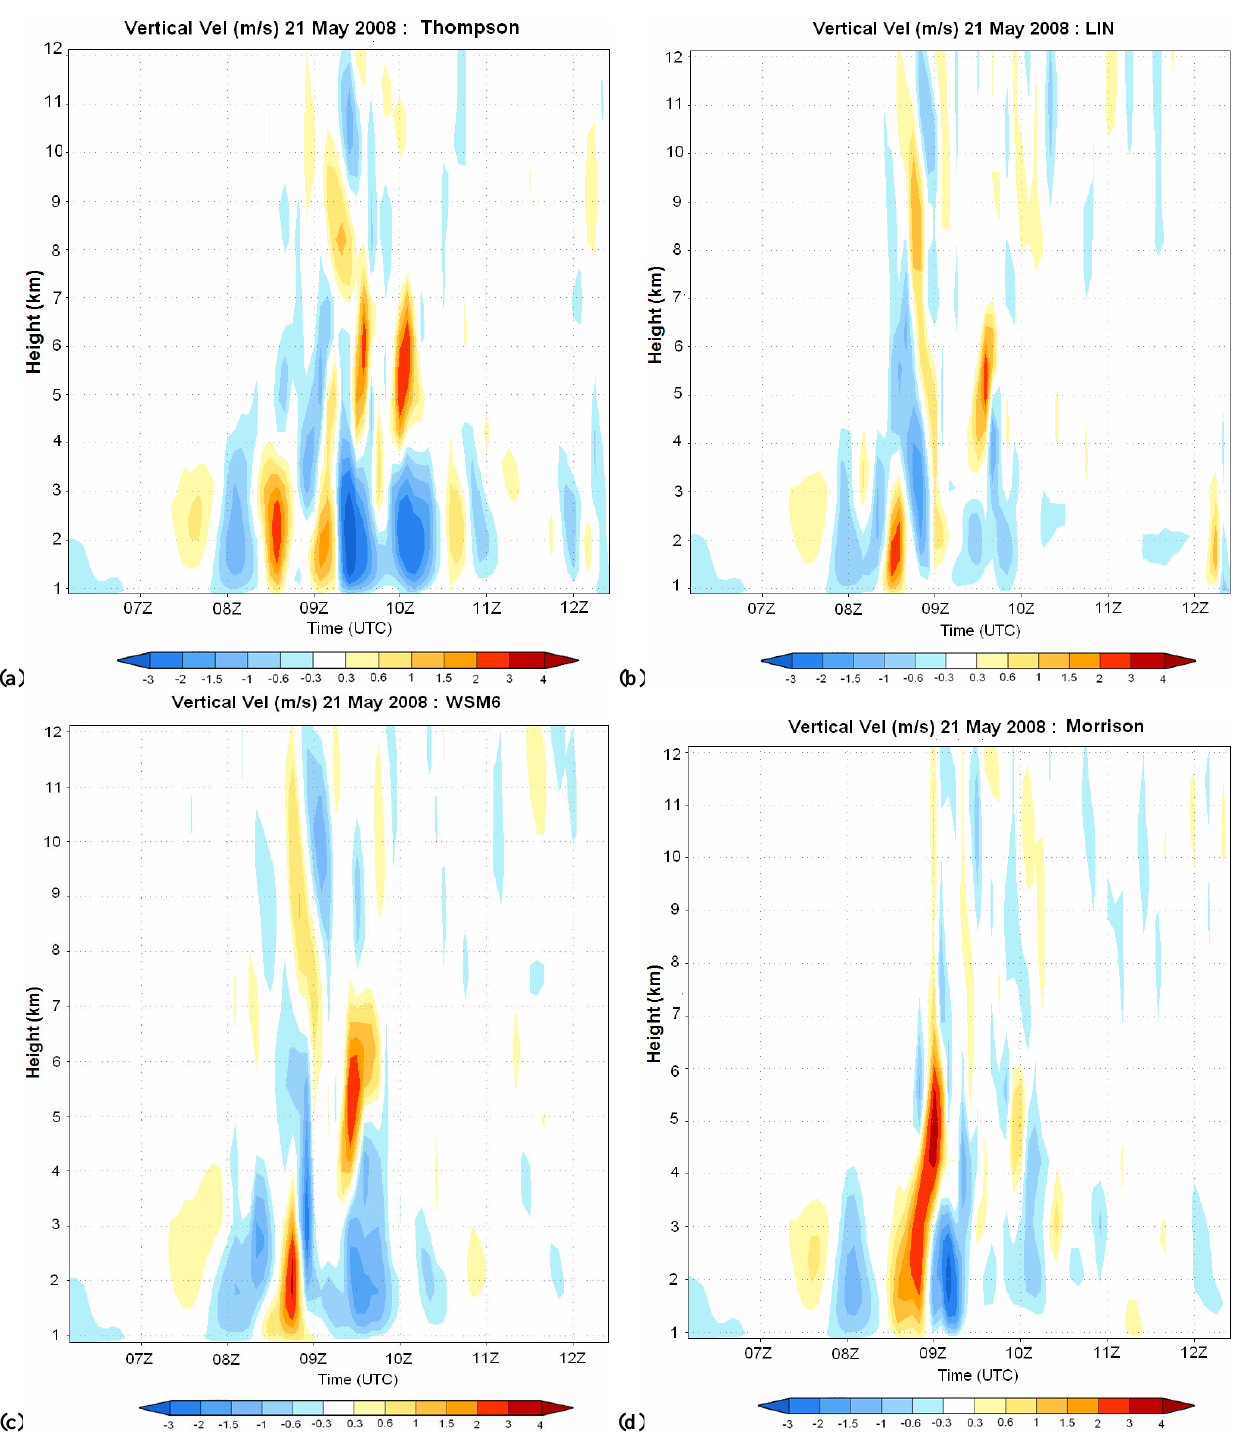
Fig. 6. Model simulated (inner most domain) vertical velocity (ms − 1 ) over Gadanki with (a) Thompson, (b) Lin, (c) WSM6, and (d) Mor- rison. Positive (negative) values refer to updraft